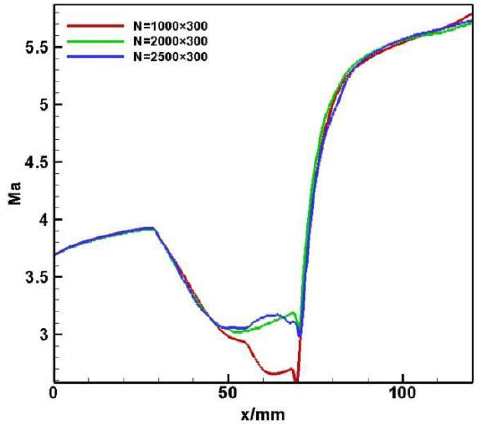
Figure 3. Distribution of Mach number along the streamwise direction of the centerline of the flow field in different grid condition.